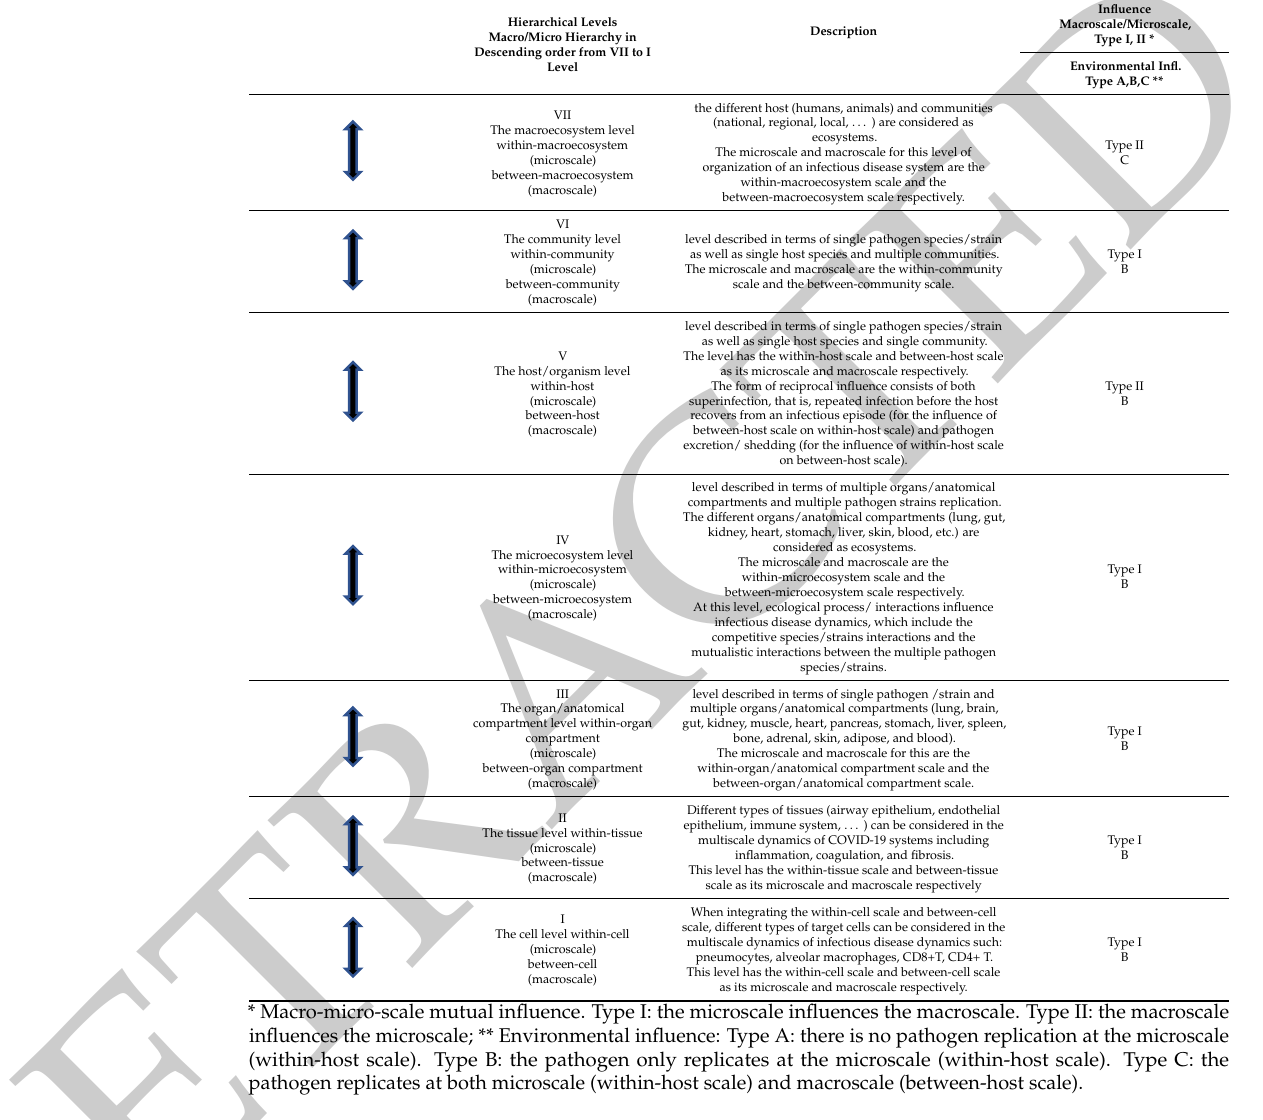
Table 4. Conceptual diagram of the seven hierarchical levels of organization of an infectious disease system and associated macroscale and microscale. Types of reciprocal influences between macroscale, microscale, and environment related to SARS-CoV-2 infection processes. Free adapted and modified from Garira (2020).